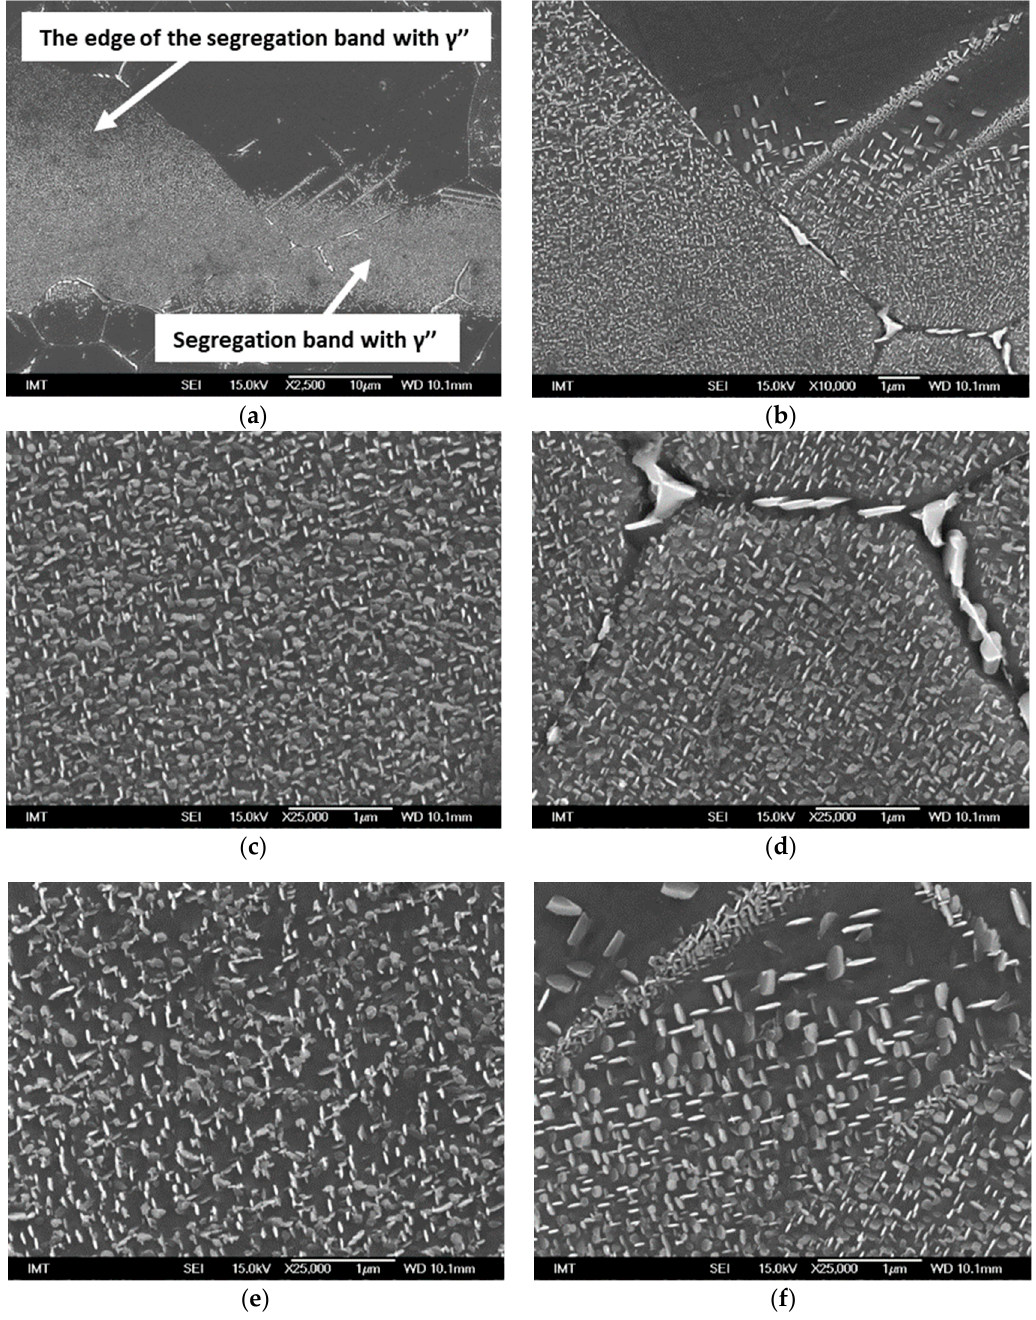
Figure 11. Segregation band of the sample hot rolled at 1050 ◦ C with the deformation level of 23.5% and aged at 750 ◦ C for 25 h ( a , b ). The precipitation of the γ ” in the segregation band of the deformed grain ( c ) and the recrystallized grain ( d ). The difference between the precipitation at the edge of the segregation band in the deformed ( e ) and the recrystallized grain ( f ).